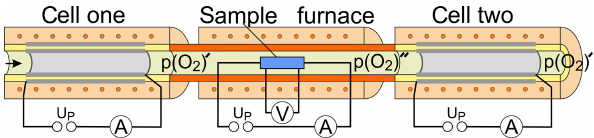
Figure 1. Schematic representation of the titration setup consisting of an oxygen titration cell (cell one), a sample furnace with a holder for four-point measurements, followed by a second oxygen titration cell (cell two).